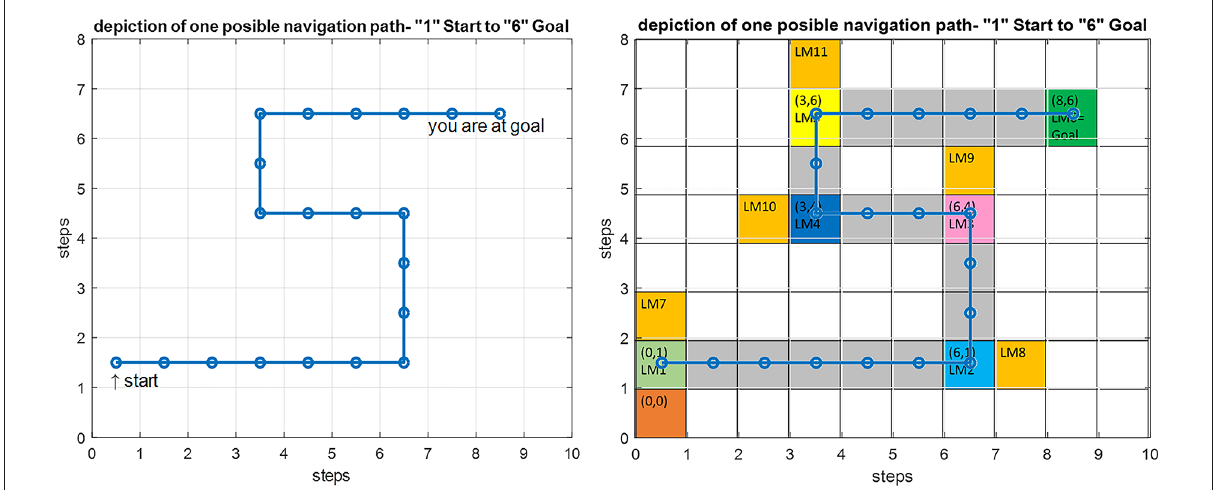
FIGURE12 Left: Simulation result for the implemented proposed navigation model in Matlab. Right: An overlay of the simulation output on the predefined route shown in gray with the starting point at LM1 and the goal at